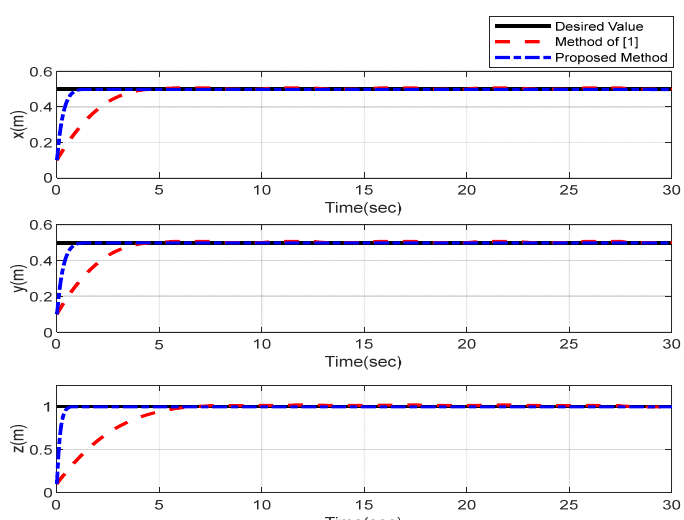
Figure 2. Position tracking of quadrotor using non-singular TSMC method. Table 3. Parameters of the control strategy , ∀𝑖 (cid:3404) 𝑥 , 𝑦 , 𝑧 , 𝜙 , 𝜃 , 𝜓 .